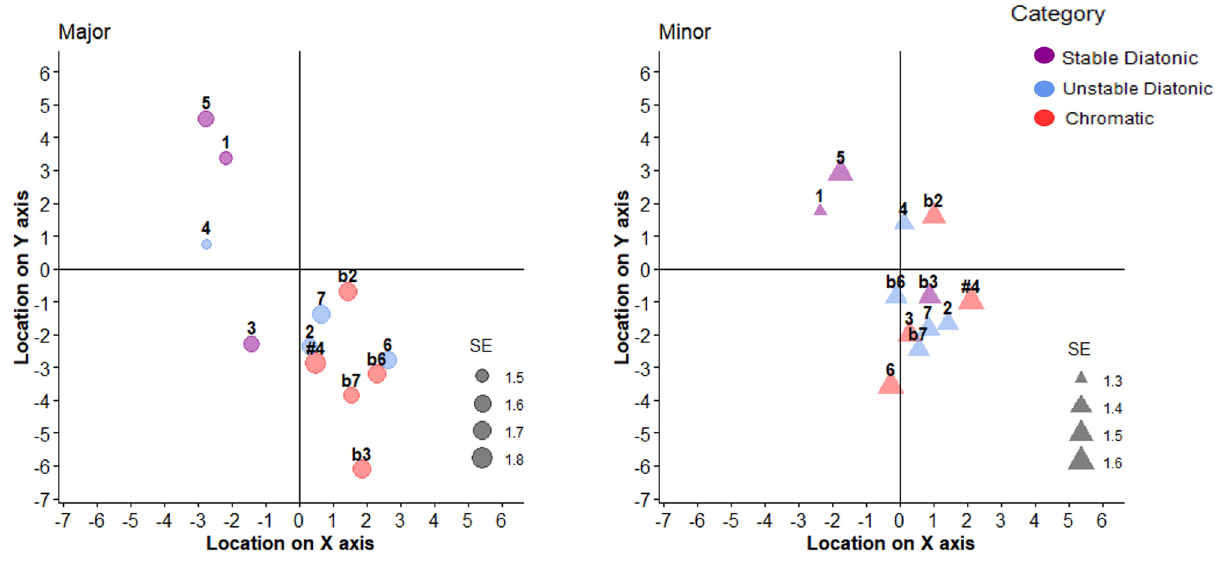
Figure 3. Mean localizations of each Major (left panel, circles) and Minor (right panel, triangles) scale degrees in semitones, in Experiment 1, as a function of tonal stability category (stable diatonic = purple, unstable diatonic = blue, and chromatic = red) and standard errors (relative size). Scale degrees are normalized into C Major and C minor (i.e., 1 = the tonic scale degree), # symbols represent raised degrees (e.g., #4 = = the triton), and b symbols represent lowered degrees (e.g., b2 = = lowered second). On both axes, the means never exceeded the [− 7, + 7] window presented here (the full scale ranged between – 50 and + 50).